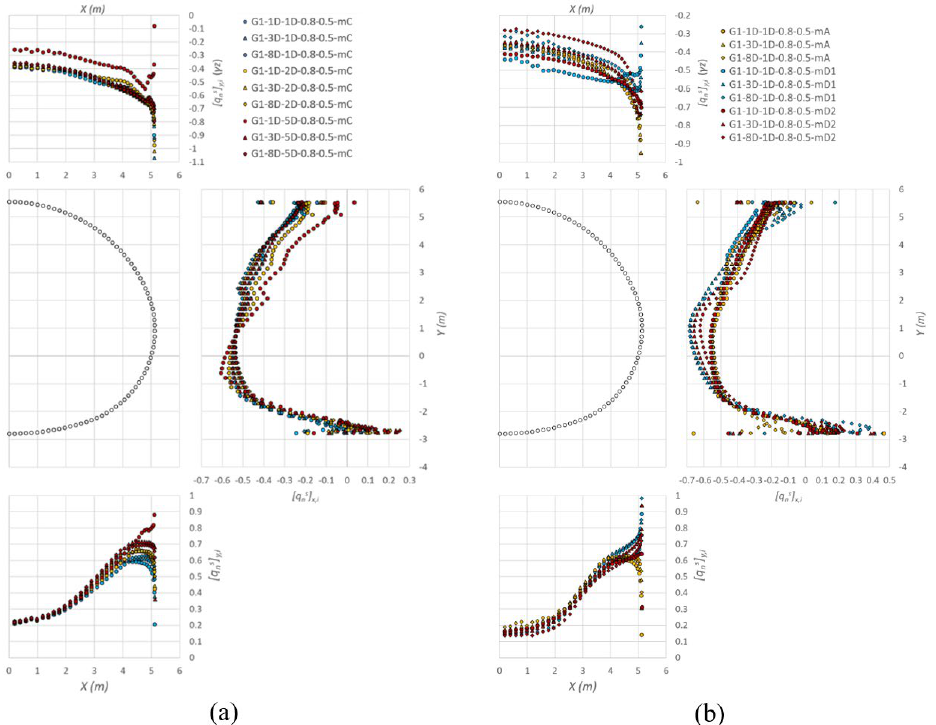
Figure 12. Normalized “ideal” compatibilization load for scenarios varying: (a) the distance between invert bottom and model bottom for geometry G1; (b) constitutive models for geometry